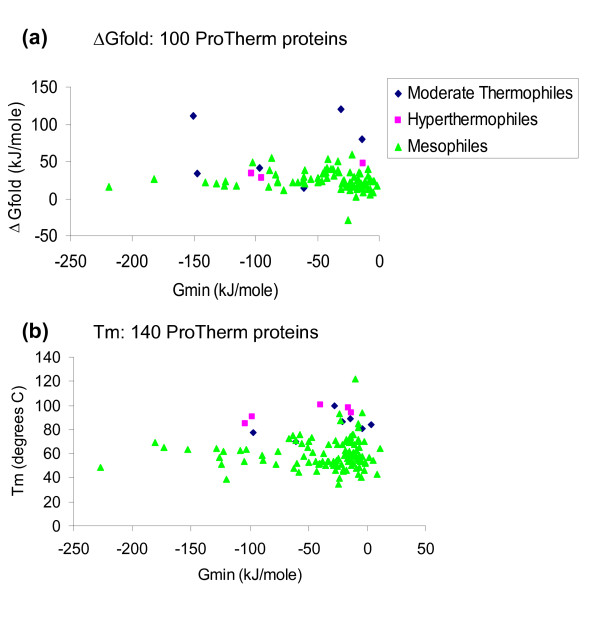
ProTherm data, and calculations. (a) Scatter plot with ΔGfold for 100 proteins in the ProTherm database and calculated Gmin. Whereas ProTherm records ΔGfold as more positive for a more favoured folded state, Gmin calculations are in the opposite sense. (b) Scatter plot with the melting temperatures for 140 proteins in the ProTherm database and calculated Gmin.